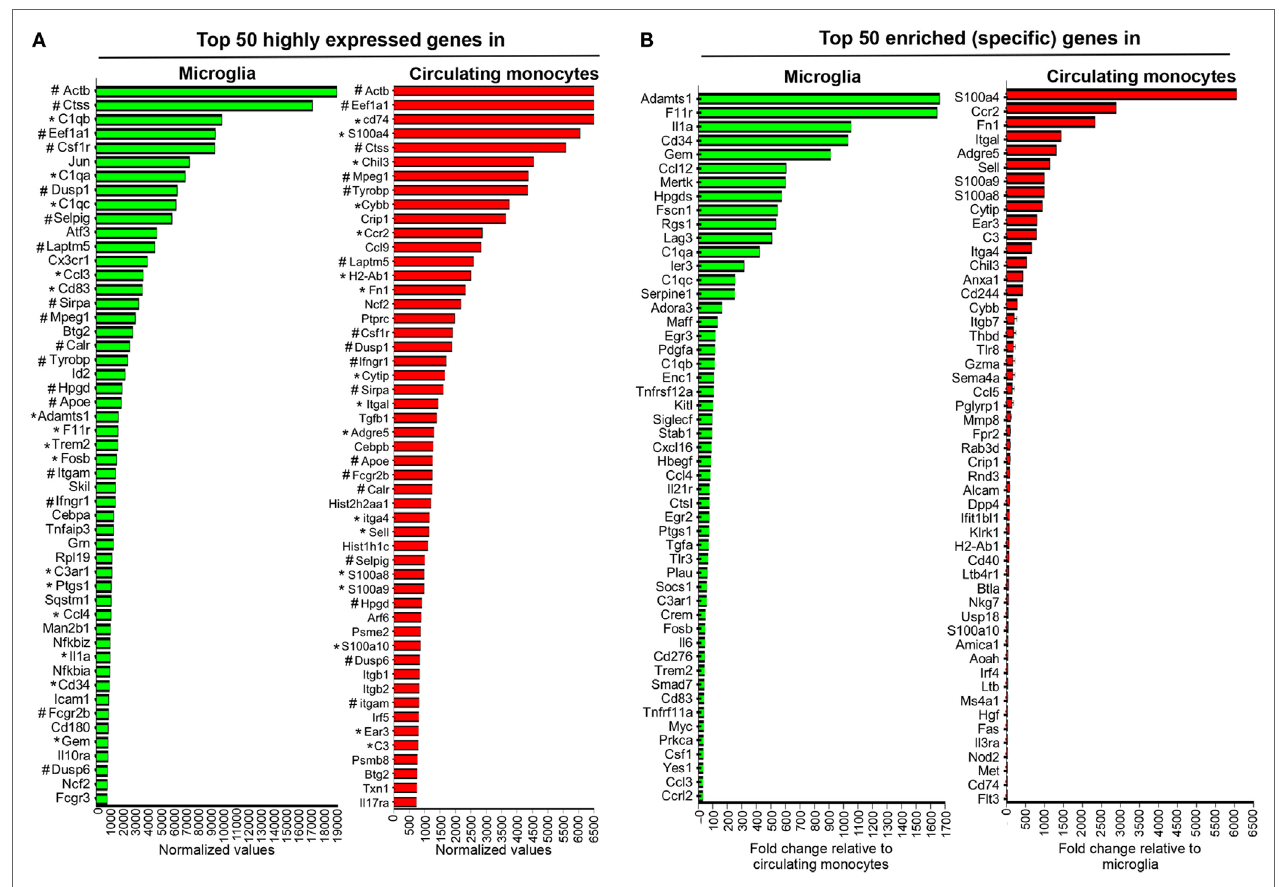
FigUre 3 | Gene expression characterizing microglia and circulating monocytes under homeostatic conditions. Spinal cord-derived microglia (CD45 low CD11b + CX3CR1 GFP + ) and circulating blood monocytes (CD11b + CCR2 RFP + ) were purified from naïve CX3CR1 GFP/ + CCR2 RFP/ + mice by FACS and RNA subjected to nCounter analysis using the myeloid cell probe panel. Panel (a) depicts the top 50 highly expressed genes and (B) the enriched genes uniquely characterizing each population. In (a) * highlights genes that are both highly expressed and enriched in each population, while # highlights genes highly expressed and common to both microglia and circulating